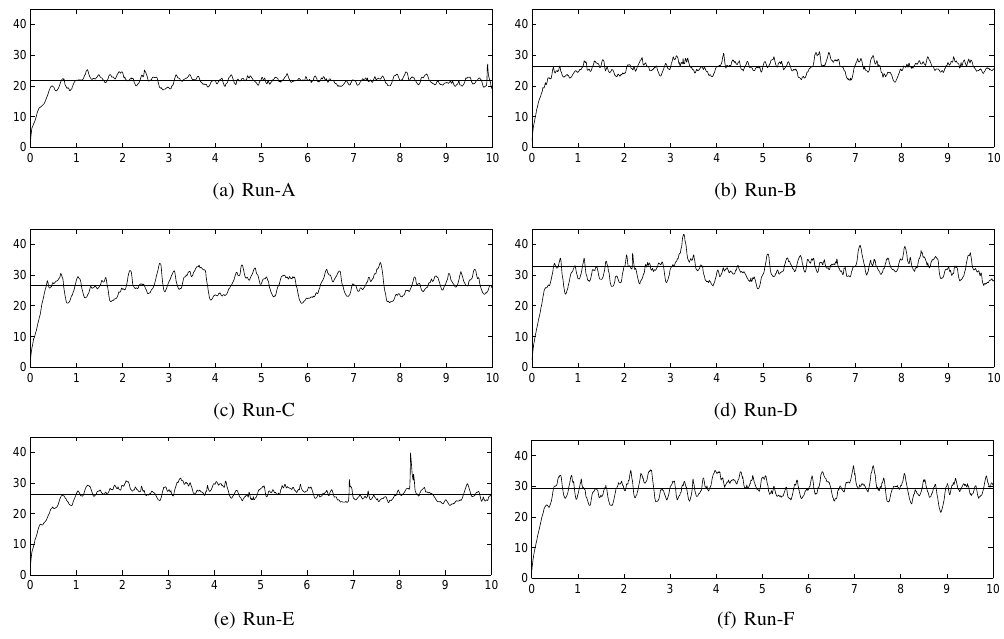
Fig. 2. Temporal evolutions (model time, years) of volume-averaged kinetic energy [cm 2 s − 2 ] for the six numerical experiments. The horizontal lines indicate the 10-year mean values.